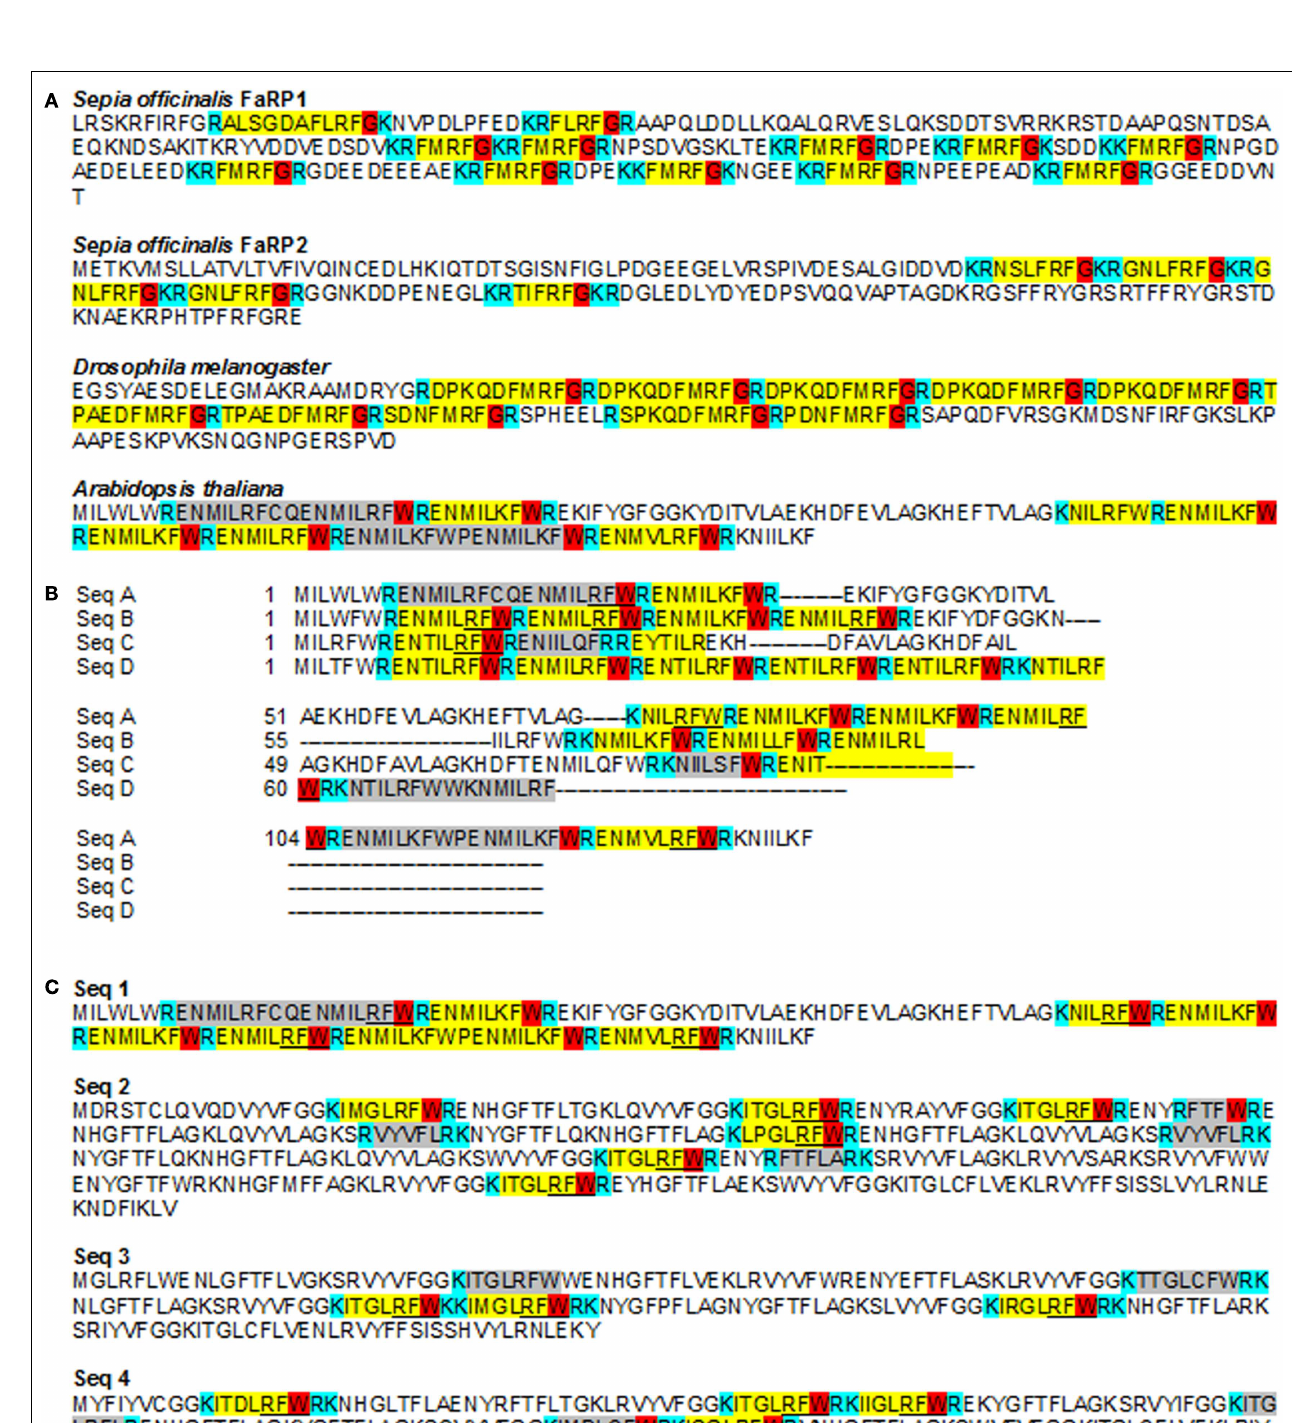
showing the diversity of FaRP between species, in the same species and in the same gene. For example, two different genes coding for FaRPs were